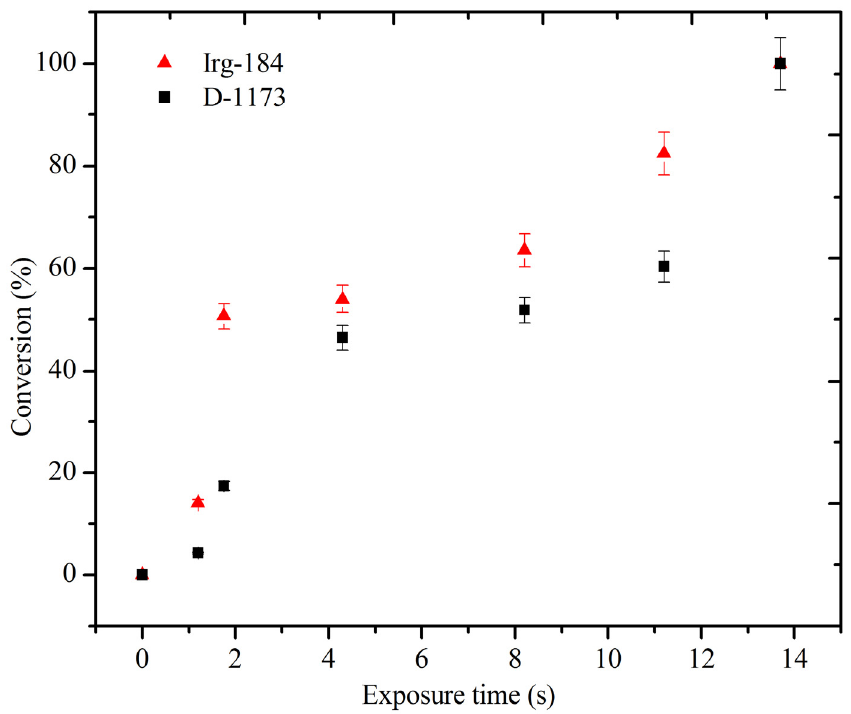
Figure 8. The Conversion of C=C in EPOLA UV cured Films ( ■ ) Photoinitiator D-1173 ( ▲ ) Photoinitiator